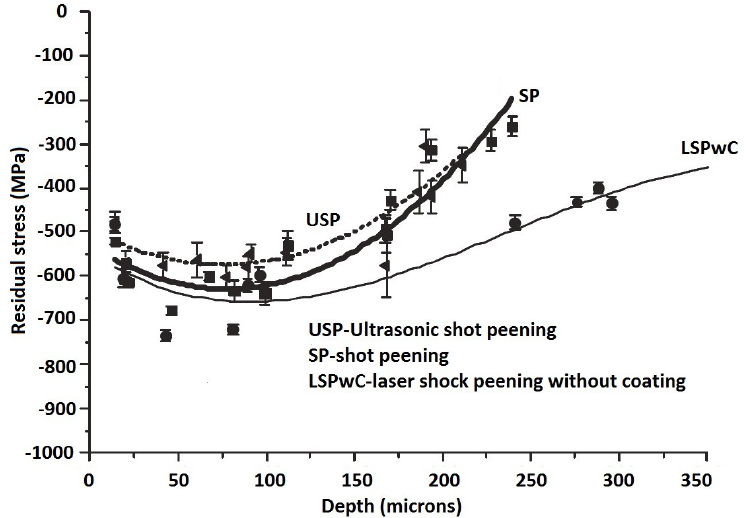
Figure 3. Residual stress-depth profiles in alpha phase of Ti-2.5Cu after LPwC, SP and ultrasonic shot peening (USP)